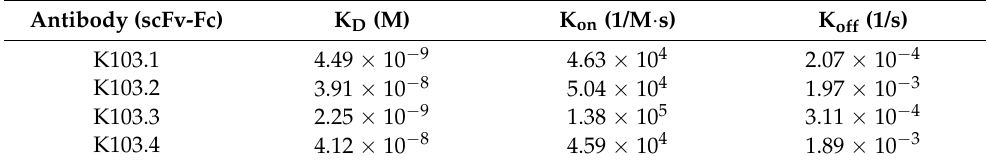
Table 1. SPR analysis of the binding affinities of the selected scFv-Fc clones to MF-hCADM1. Antibody